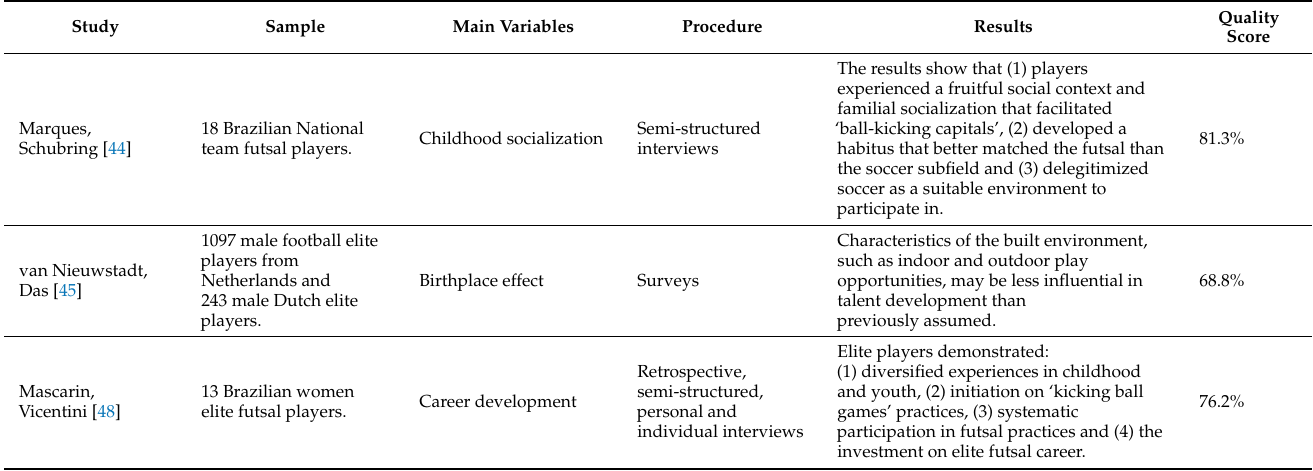
Table 8. Studies with socio-cultural influences analysis.